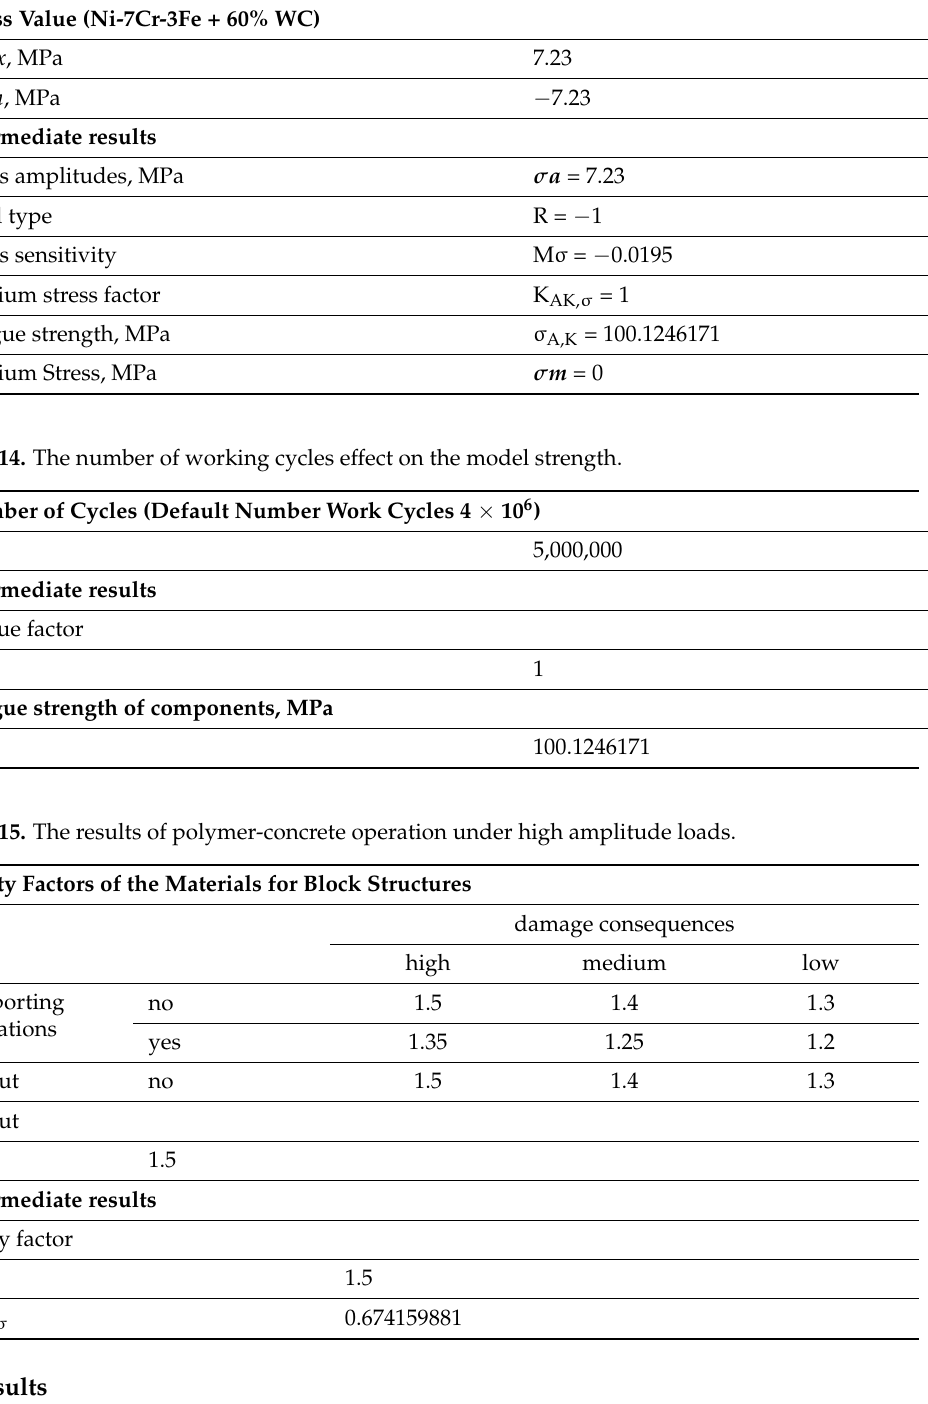
Table 13. The results of calculating the internal stress distribution.